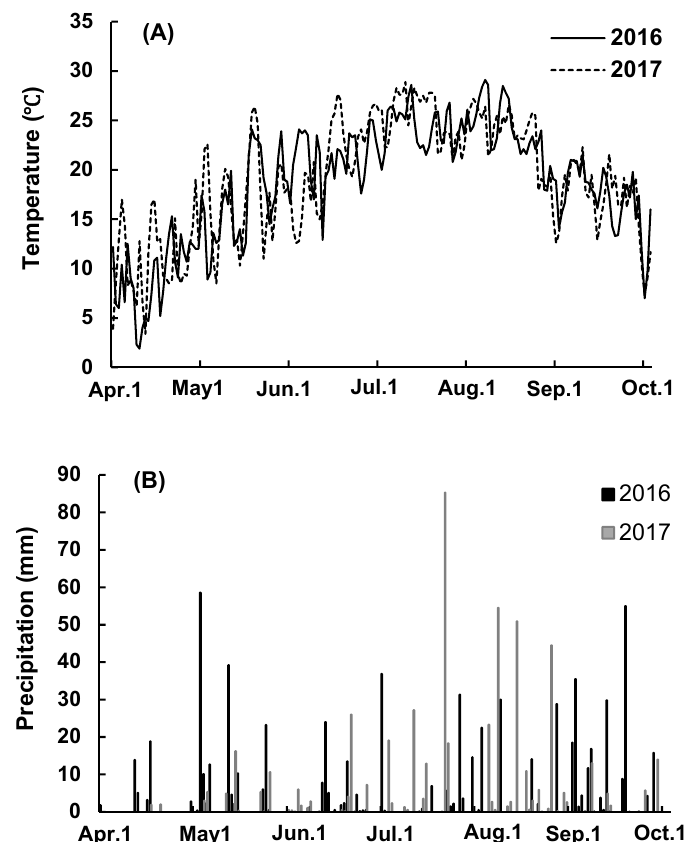
Figure 1. Daily temperature ( A ) and precipitation ( B ) during the maize-growing season in 2016 and 2017 at the experimental site.